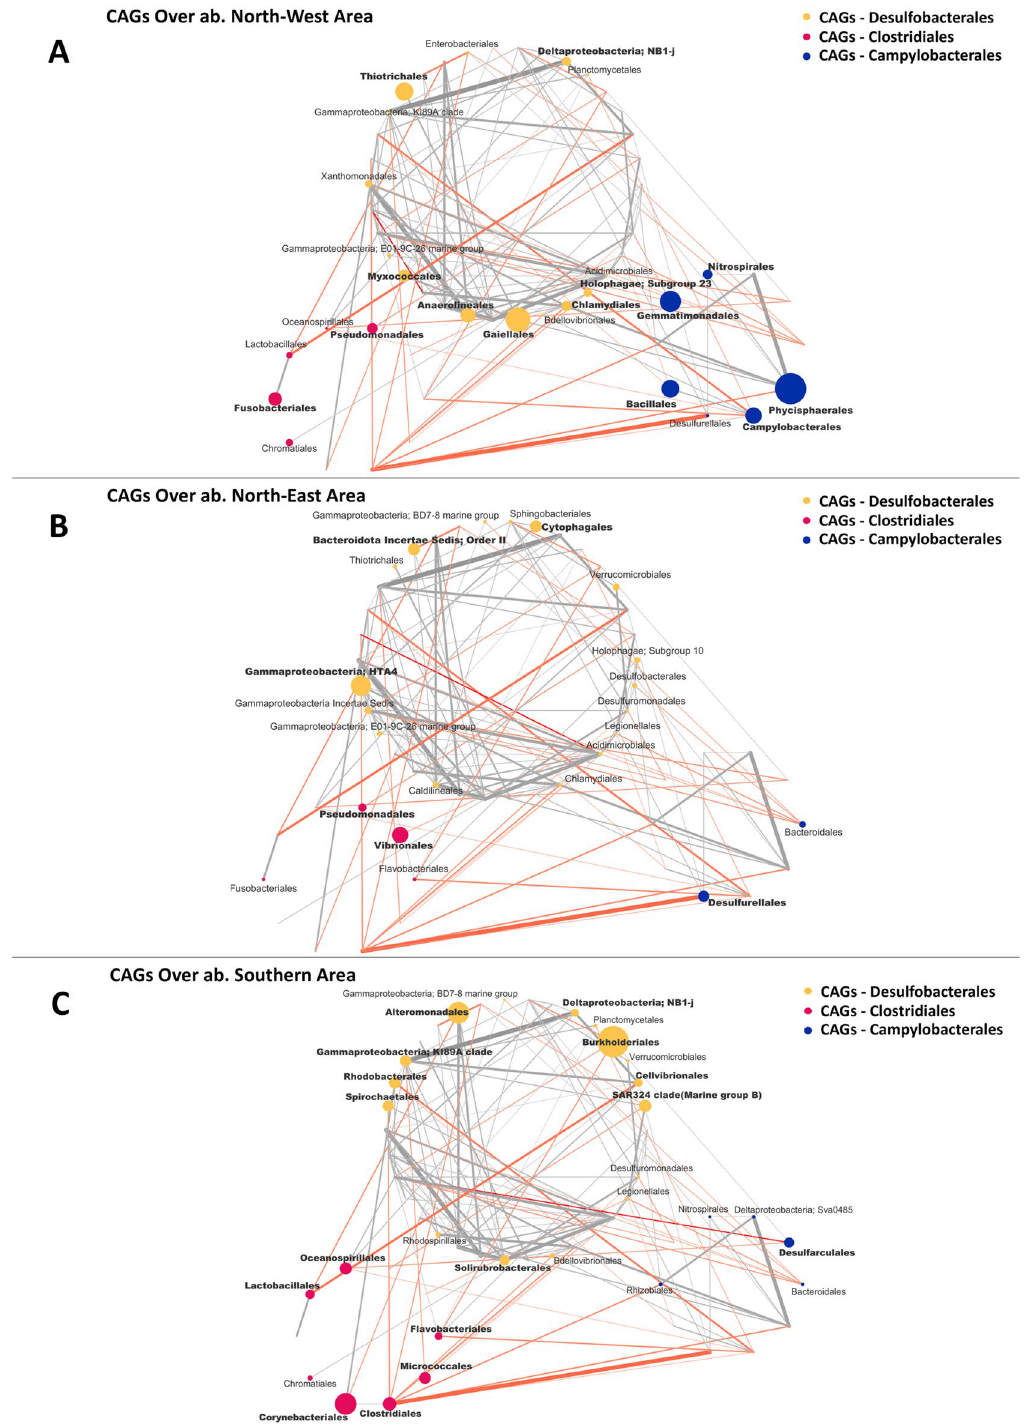
Figure 8. Wiggum plots representing the over-abundance of each bacterial order in the 3 CAGs in the sediment ecosystem in each Area: ( A ) North-West Area; ( B ) North-East Area and ( C ) Southern Area. CAGs are named according to the most abundant order in each CAG and are colour coded as follows: Desulfobacterales (Ocher), Clostridiales (Pink) and Campylobacterales (Blue). Each bacterial order is depicted as a node whose size is proportional to its over-abundance. Node and name of a bacterial order with an over-abundance < 1 are not represented, and those with an over-abundance ≥ 1.3 are